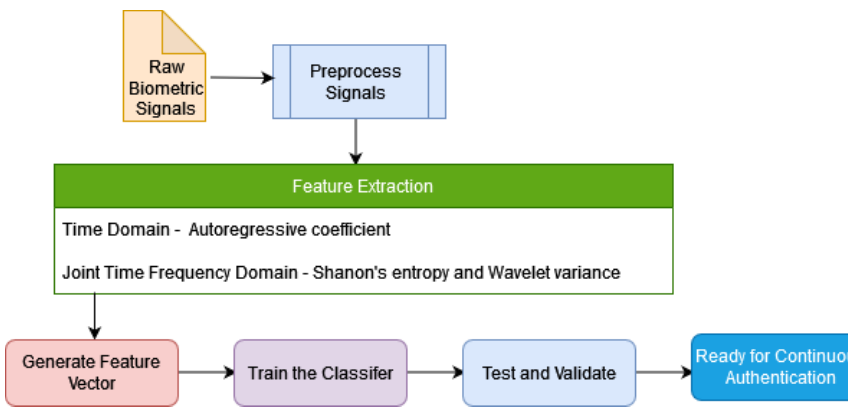
Figure 5. Feature Extraction for the Proposed